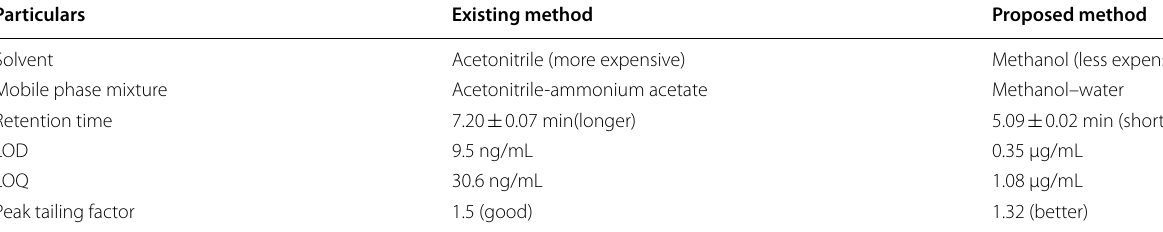
Table 8 Comparison between existing and proposed method